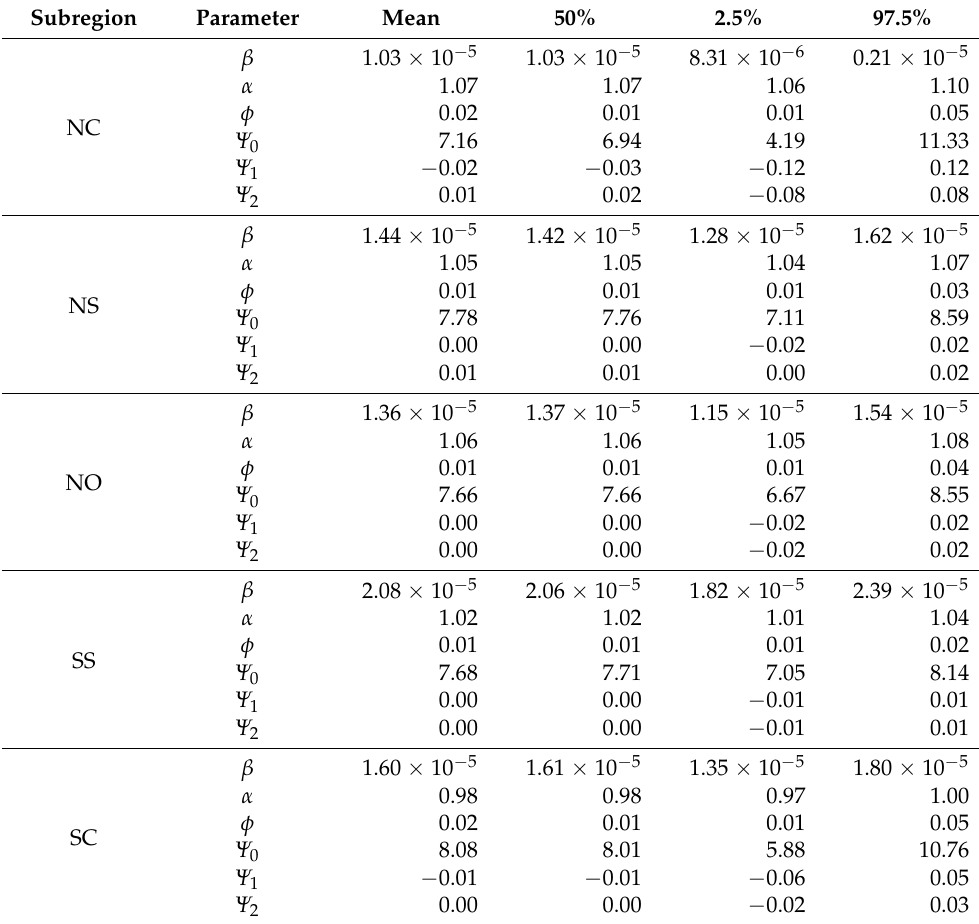
Table 3. Posterior mean, median and 95% credibility interval for the parameters β , α , φ , σ 2 and Ψ (cid:48) = ( Ψ 0 , Ψ 1 , Ψ 2 ) ( Ψ 0 is the intercept, Ψ 1 is the coefficient associated with longitude and Ψ 2 is the coefficient associated with latitude) of the model adjusted for an estimate of the R* mm index in the NC, NS, NO, SS and SC